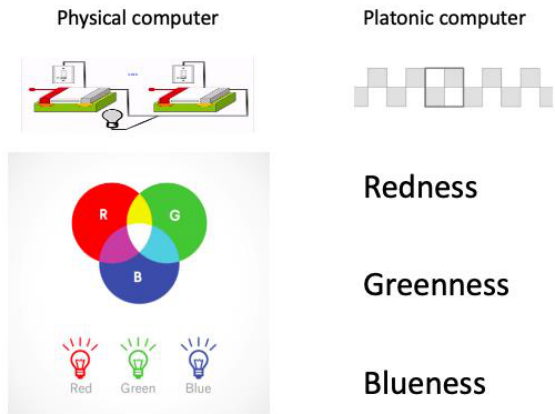
Figure 5. Phenomenological colors as output of a physical computer ( left ) and abstract colors as output of Platonic computer ( right ).